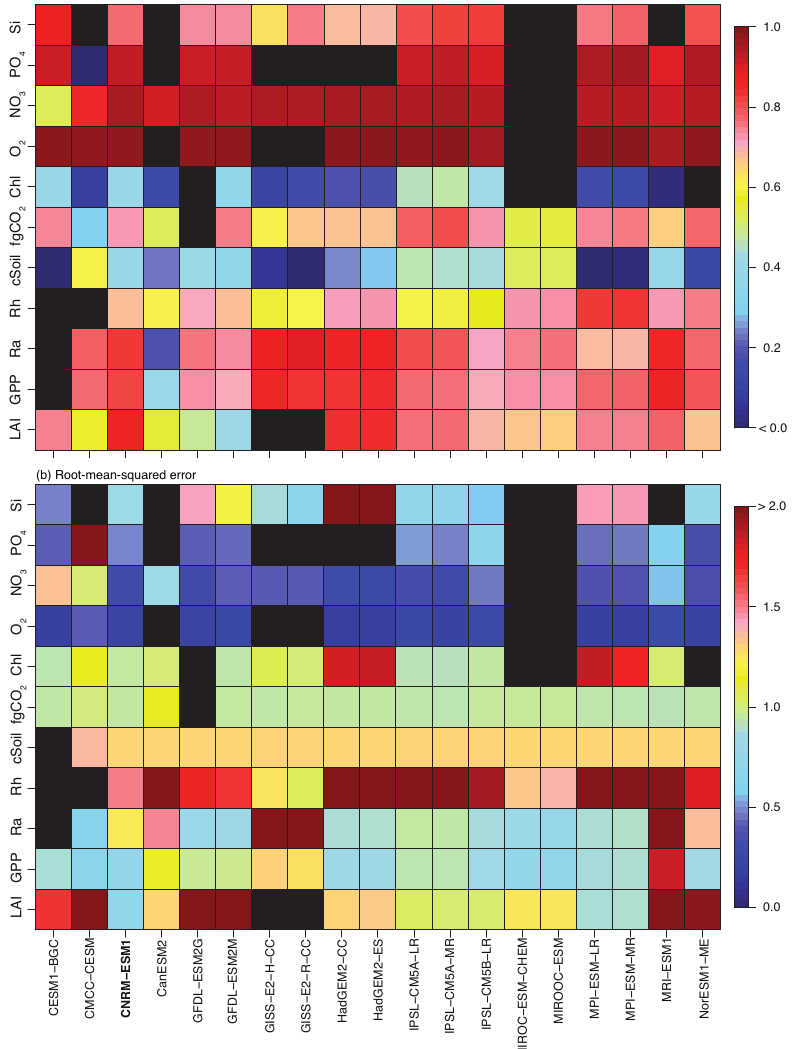
Figure 20. Skill-score matrix based on (a) spatial correlation and (b) globally averaged root mean squared error for relevant fields of the simulated carbon cycle from current generation Earth system models. Leaf area index (LAI), gross primary productivity (GPP), autotrophic respiration (Ra), heterotrophic respiration (Rh) and soil carbon (cSoil) are used to assess model skill in terms of modern mean-state terrestrial carbon cycle. Sea–air carbon flux (fgCO 2 ) , surface chlorophyll (Chl) and surface concentrations of oxygen (O 2 ) , nitrate (NO 3 ) , phosphate (PO 4 ) and silicon (Si) are used to evaluate the skill of the current models at replicate modern mean-state ocean carbon cycle. Both models and observed fields are averaged over time from 1986 to 2005 to determine skill score metrics, except for cSoil, O 2 , NO 3 , PO 4 , Si observations (only a modern mean-state climatology is available). Black squares indicate that models fields are not available (implying that these fields are either not simulated by the model or not published on the Earth System Grid Federation,